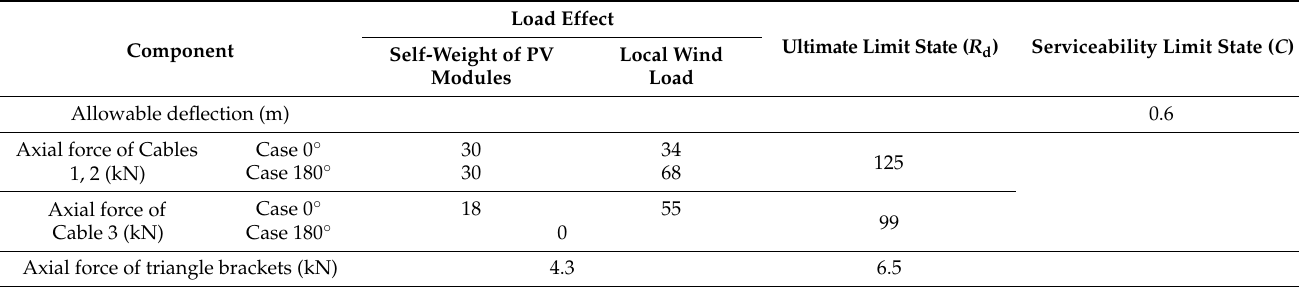
Table 4. Required internal force of cables and triangle brackets.